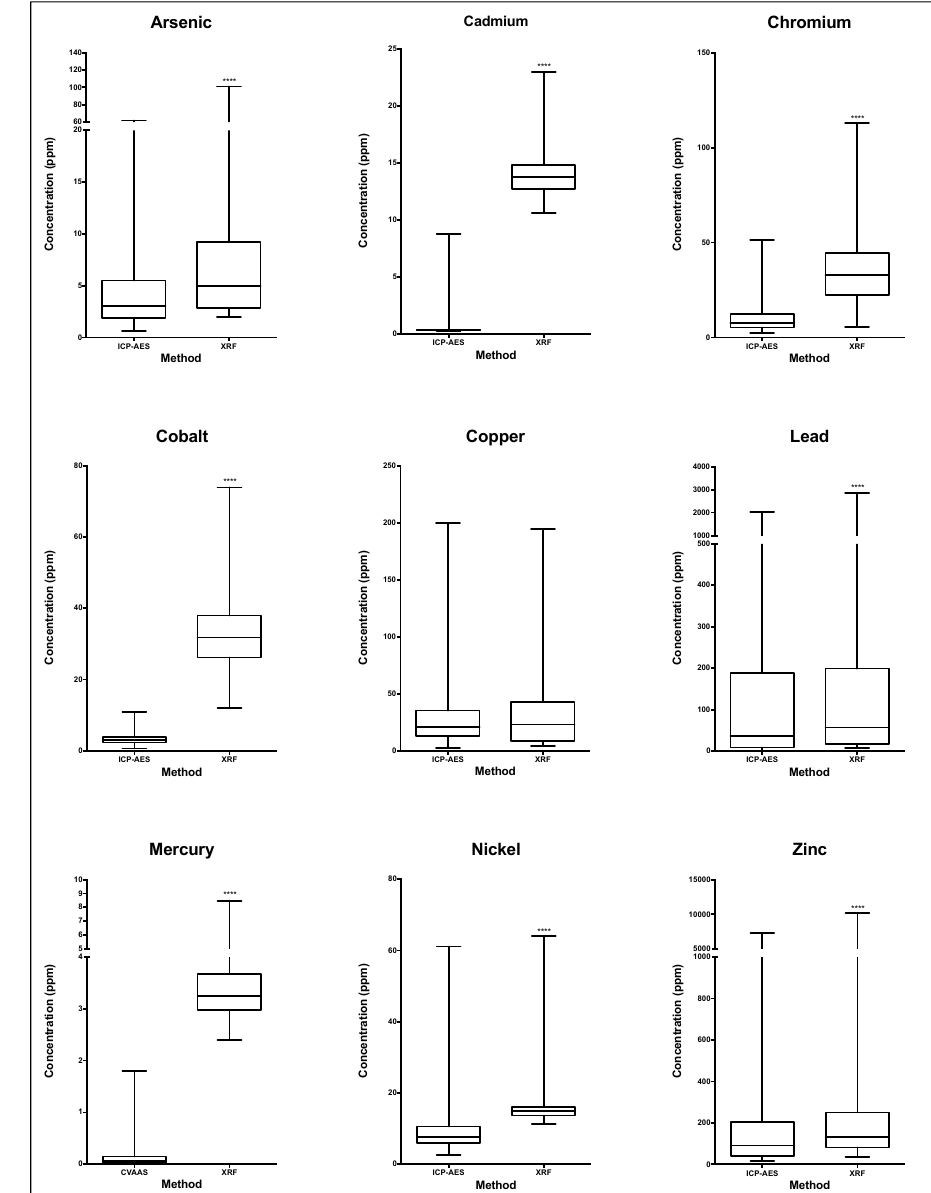
Figure 1. Wilcoxon T-test Results for All Metals Comparing Laboratory Analyses and XRF Reported